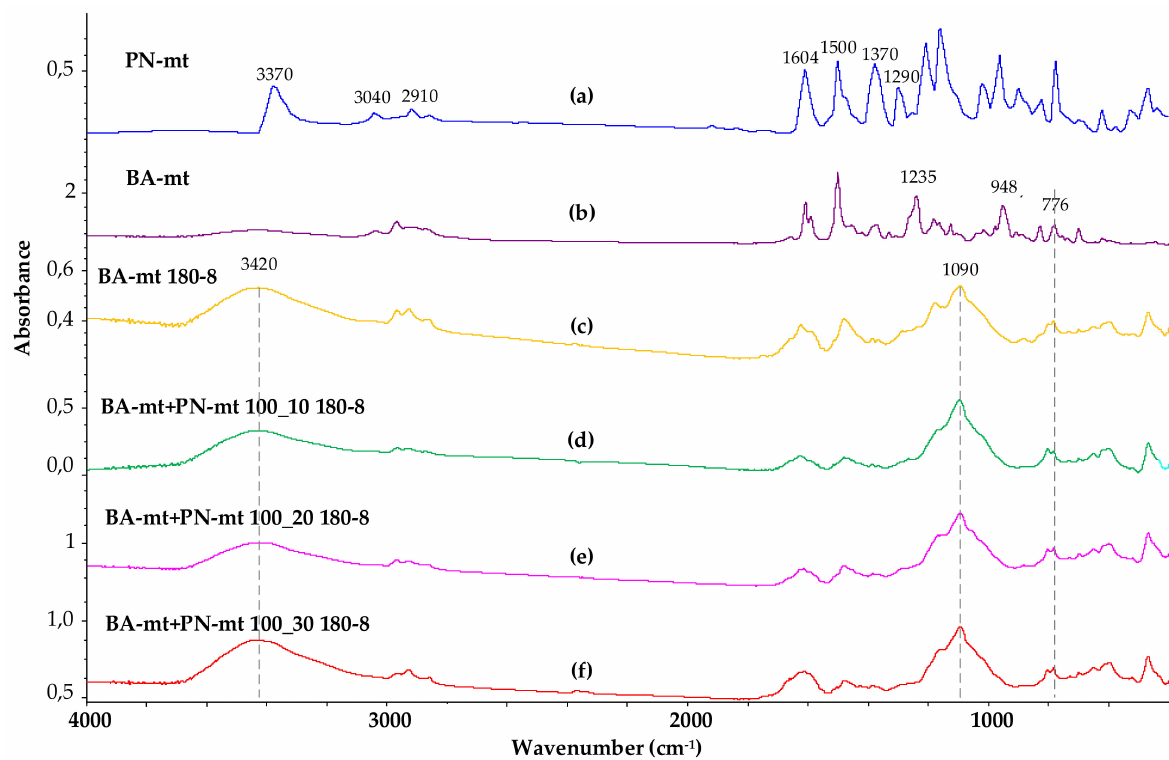
Figure 10. FTIR spectra of PN-mt ( a ), BA-mt monomer ( b ), cured BA-mt ( c ) and cured compositions containing 100 pbw of BA-mt and 10 ( d ), 20 ( e ) and 30 ( f ) pbw of